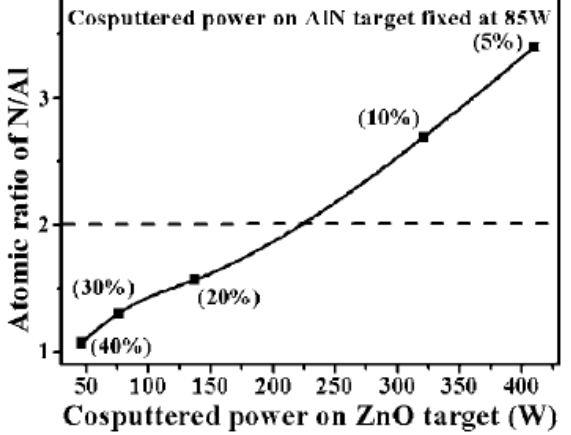
Figure 13. Atomic concentration of nitrogen to aluminum [N/Al] in the AlN–ZnO cosputtered films as a function of the rf cosputtering power on ZnO target (the theoretical Al atomic ratio [Al/ (Zn+Al) at %] is shown in bracket). Reprinted from Ref. [20] with